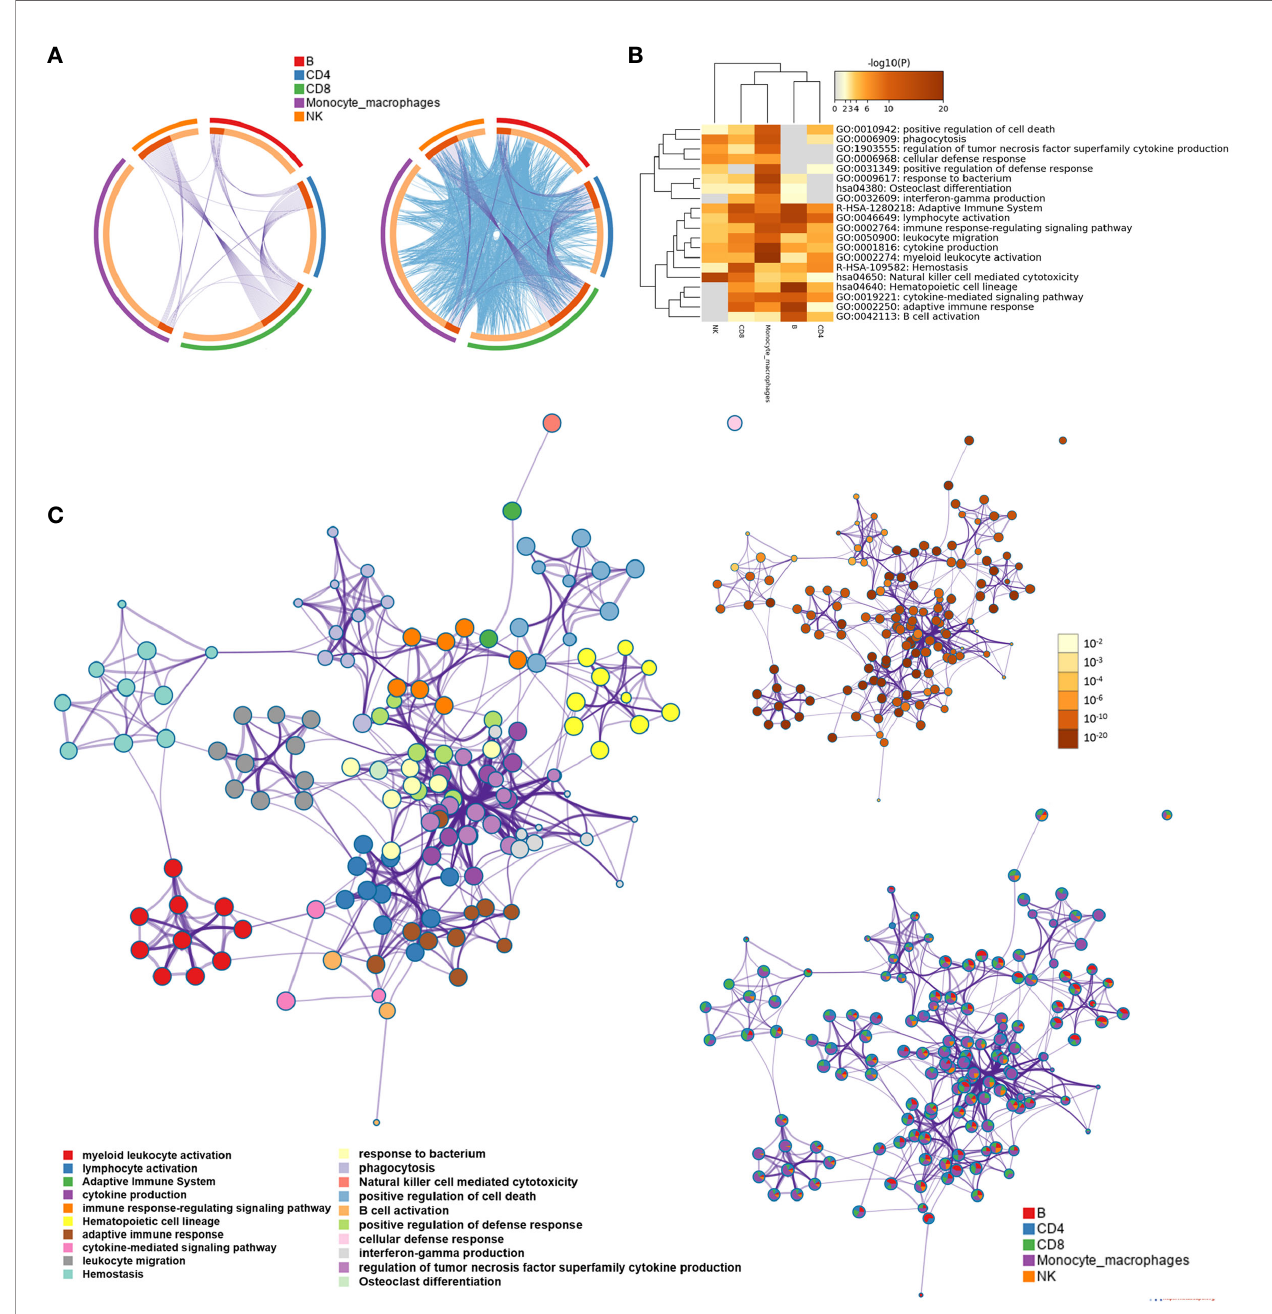
FIGURE 2 | Functional and pathway enrichment analysis for B cell, CD4+ T cell, CD8+ T cell, natural killer (NK) cell, and monocyte-macrophage cell subsets. (A) The Circos plot shows how differentially expressed genes from the given immune cell subsets overlap. Each arc represents the identity of each gene list. Purple lines link the same gene that is shared by multiple gene lists. Blue lines link the different genes where they fall into the same ontology term (the term has to be statistically signi fi cantly enriched with a size no larger than 100). (B) The heatmap cells are colored based on the P-values of the enriched terms, and white cells indicate the lack of enrichment for that term. (C) Network of enriched terms; the nodes denote the enriched terms, and terms are connected by edges with a kappa statistic of >0.3. Enriched terms in the same cluster are denoted by the same color. In addition, the same enrichment network has its nodes colored based on the P-value and displayed as pies; different color sectors represent different subsets involved in the same enrichment